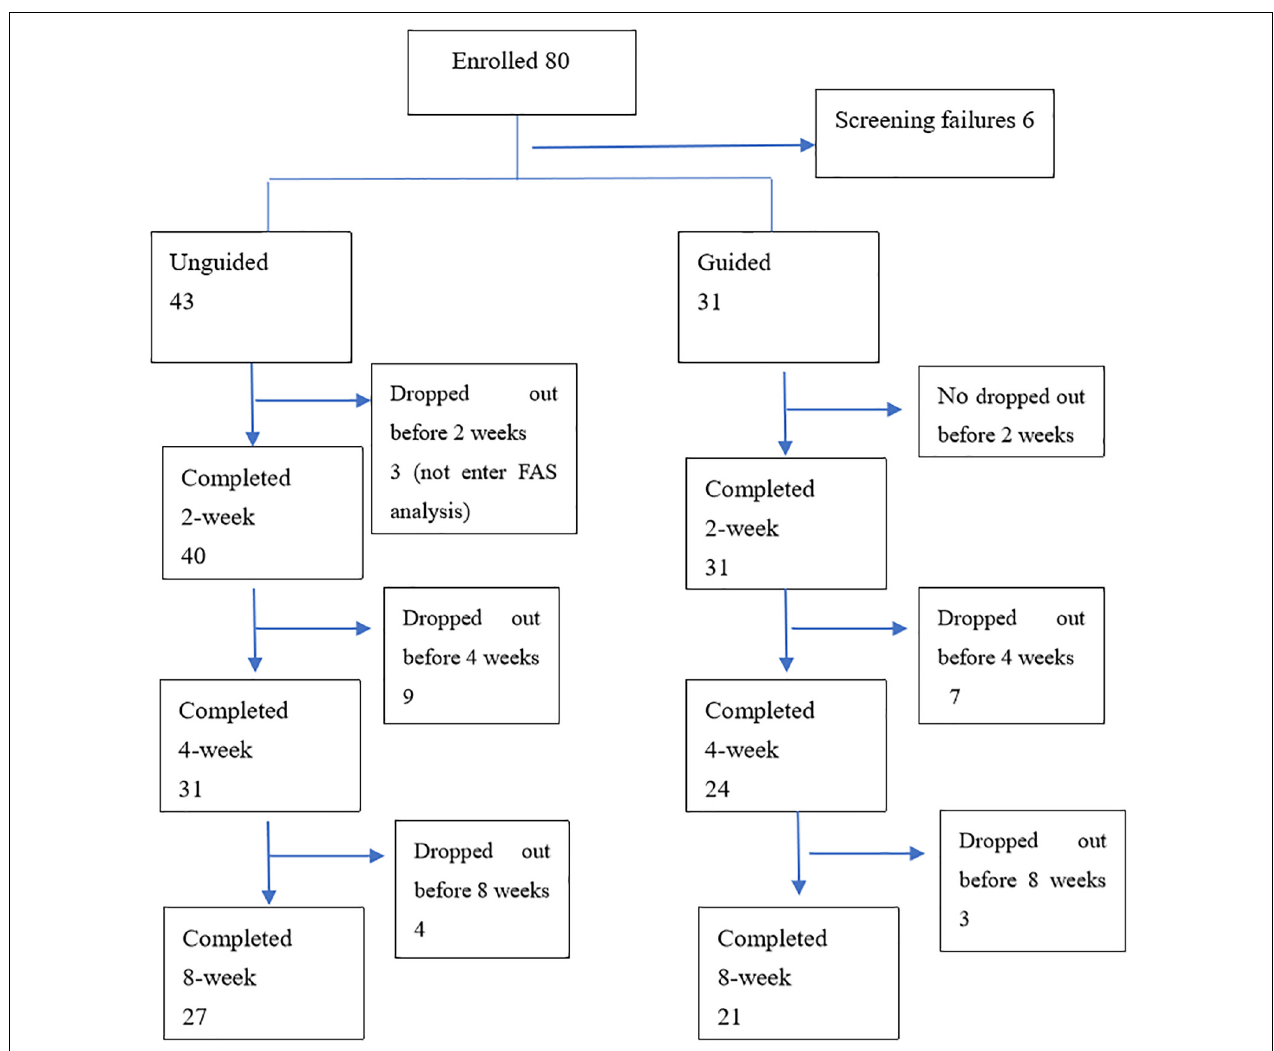
FIGURE 2 | Chart of subject accrual and